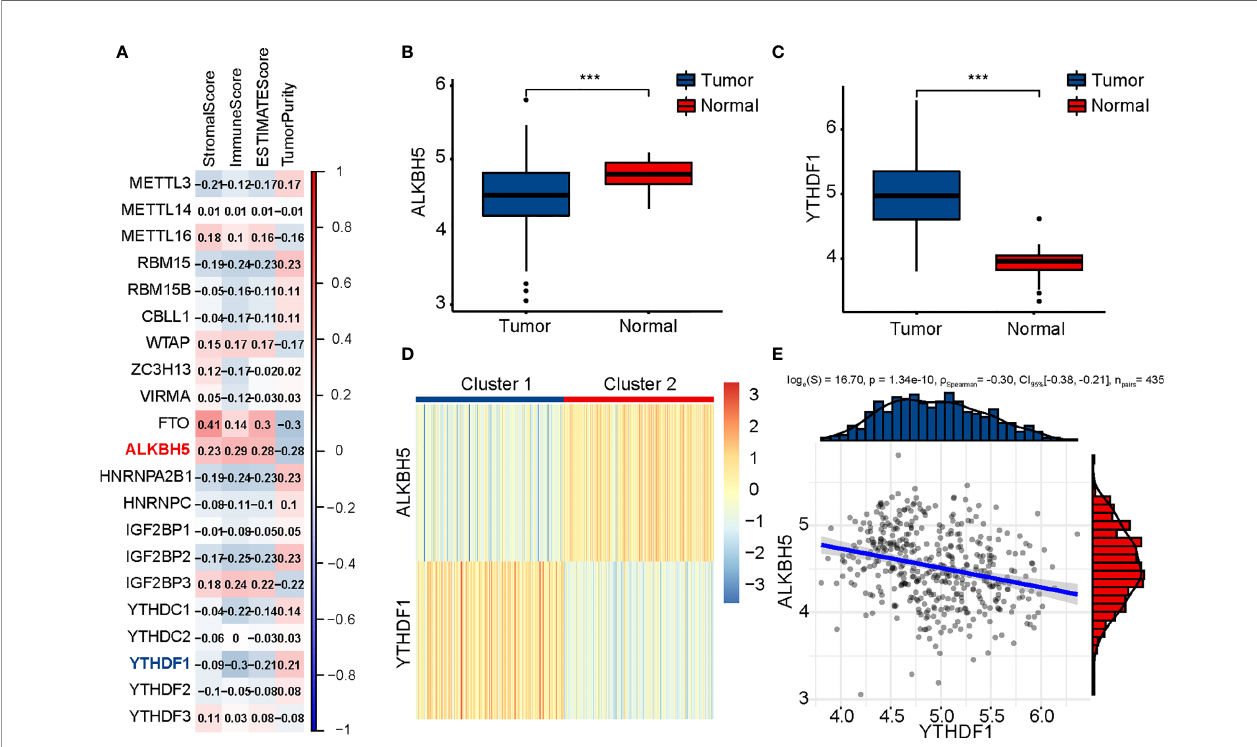
FIGURE 1 | Identi fi cation of m6A regulators related to immune score and clustering of TCGA-COAD patients based on ALKBH5 and YTHDF1. (A) Association between m6A regulators and results of ESTIMATE. (B) Comparison of ALKBH5 expression between tumor and normal tissues. (C) Comparison of YTHDF1 expression between tumor and normal tissues. (D) TCGA-COAD patients are divided into two clusters according to ALKBH5 and YTHDF1. (E) Association between ALKBH5 and YTHDF1 expression. The P values are labeled using asterisks (***P < 0.001).